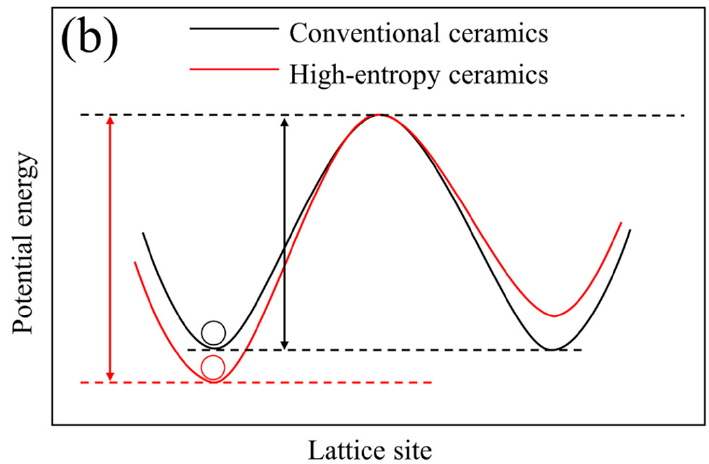
Figure 7. ( a ) Schematic diagram of lattice distortion effect in (Ca 0.5 Ce 0.5 ) (Nb 0.25 Ta 0.25 Mo 0.25 W 0.25 )O 4 high-entropy ceramics; ( b ) potential energy of ions in high-entropy and conventional ceramics. Source with permission: [168].